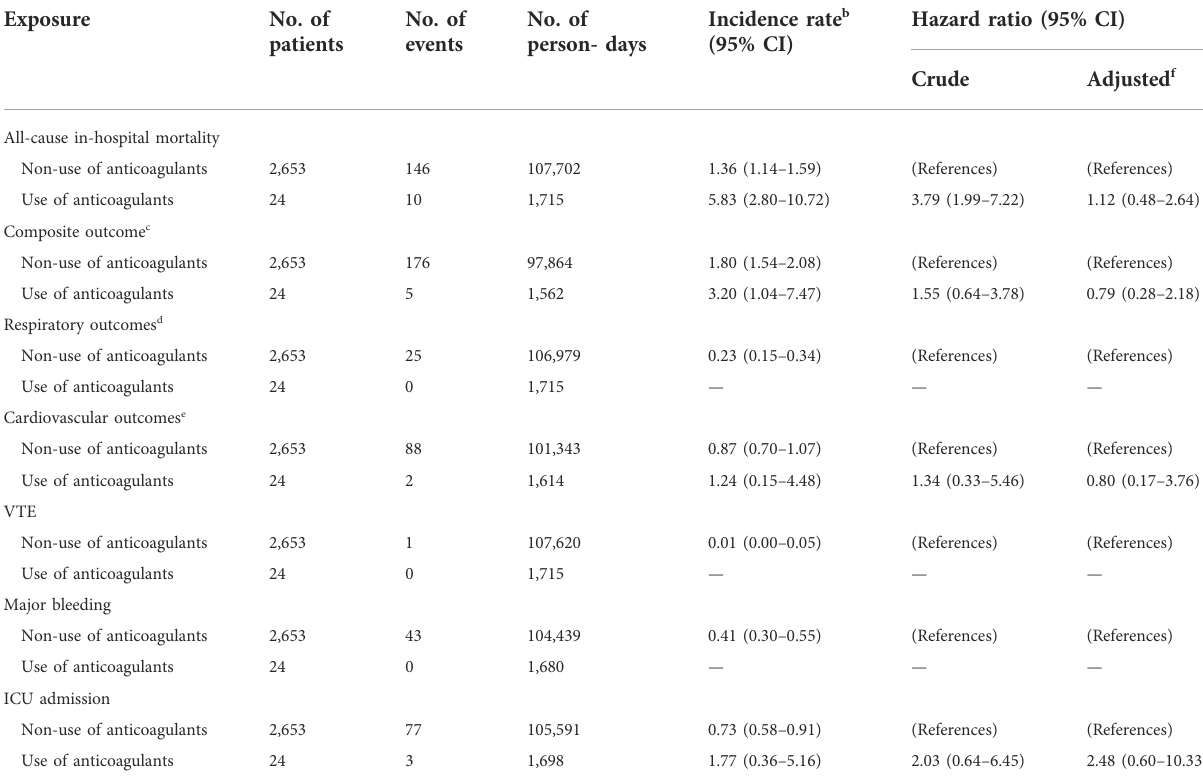
TABLE 3 Hazard ratios of adverse outcomes comparing use of anticoagulants versus non-use of anticoagulants among patients hospitalized with COVID-19 (Intention-to-treat exposure de fi nition) a